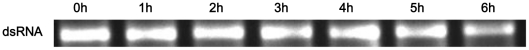
dsRNA stability on artificial diet.dsRNA on artificial was extracted and examined by electrophoresis for integrity every one hour.